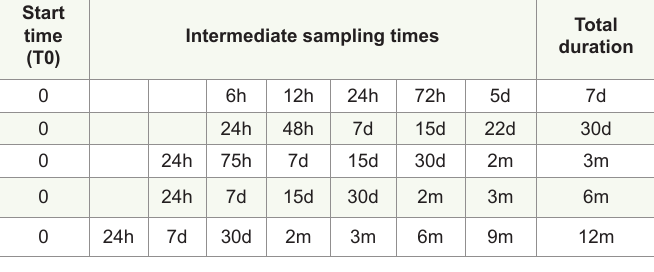
Table1 : Sampling frequencies proposed as a function of stability